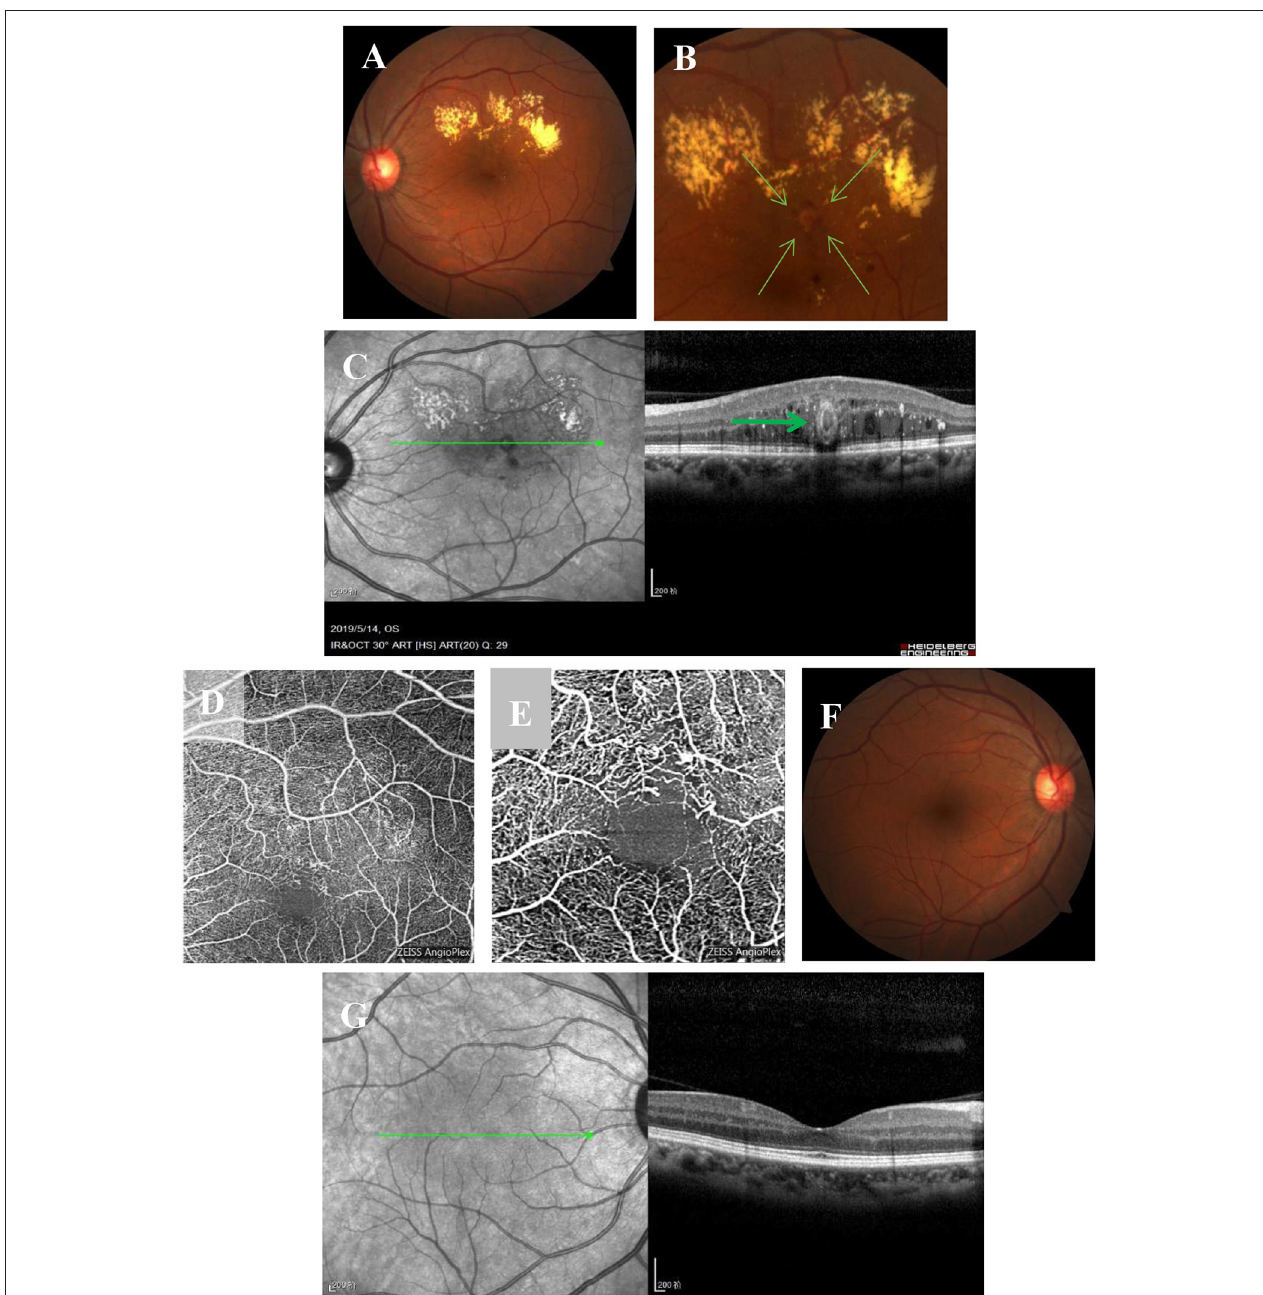
FIGURE 1 | Multimodal imaging at the initial visit. (A) Fundus examination of the left eye shows an isolated off-white lesion near the macular area and a large level of muddy-like exudate above the macular area. (B) An enlarged image of the lesion. (C) OCT imaging shows off-white lesions on transverse scanning; the lesions are bright on the outside and black on the inside with an oval ring reflection (bold green arrow), strong point reflection between layers, and edema between layers. (D) OCT-A shows sparse blood vessels, superficial vascular dilatation, and a tangled nodule beside the vessels. (E) Enlarged OCT-A image. (F,G) The fundus and OCT of the right eye are